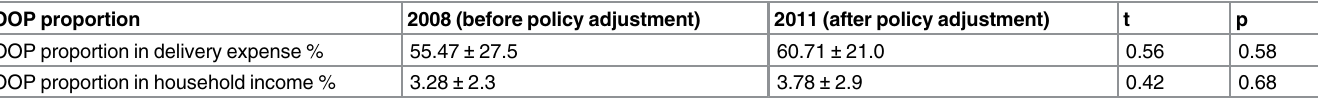
Table 4. Comparison of OOP proportion between 2008 and